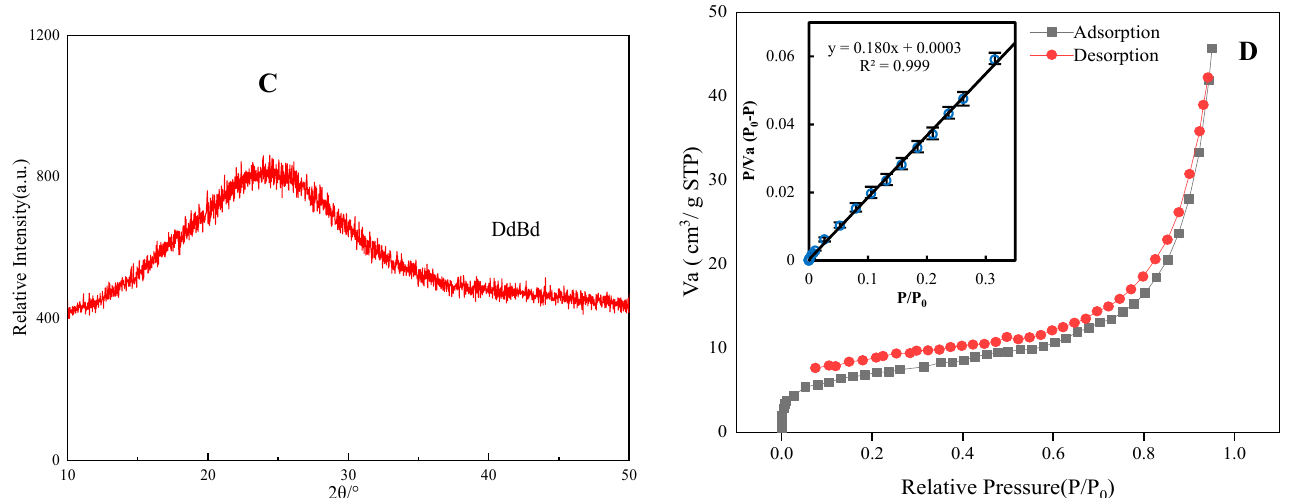
Figure A3. XRD, adsorption/desorption isotherms and energy spectrum of DdBd. ( A ) DdBd energy spectrum. ( B ) XRD of Dd and Bd. ( C ) XRD of DdBd. ( D ) N 2 adsorption/desorption isotherms of DdBd (where P is the measured air pressure, P 0 is the saturated vapor pressure of nitrogen at liquid nitrogen temperature, P/P 0 is the partial pressure of N 2 ).